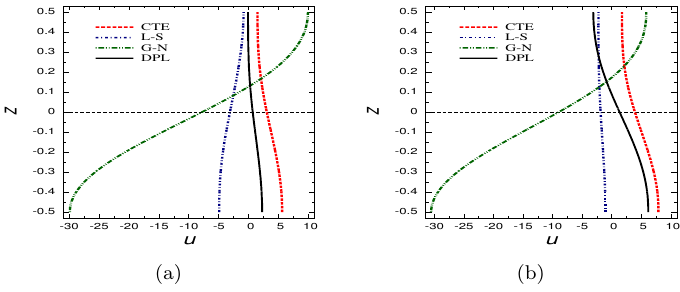
Figure 5. The axial displacement distributions in the thickness direction for beams under (a) thermal load and (b) thermomechanical load.